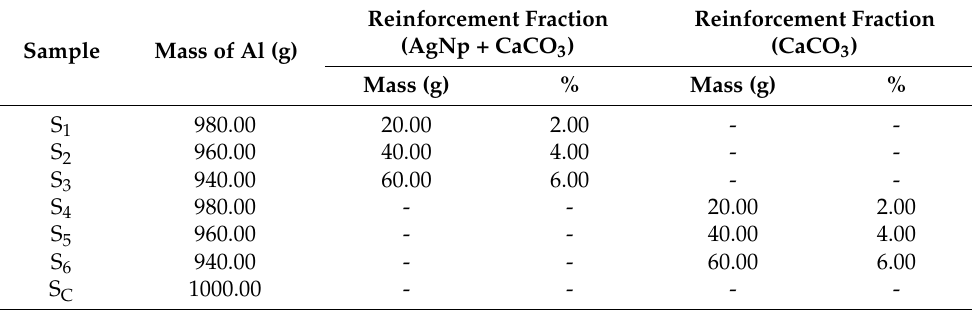
Table 1. Mixing ratio of base metal (AA6063) to reinforcements (AgNp and CaCO 3